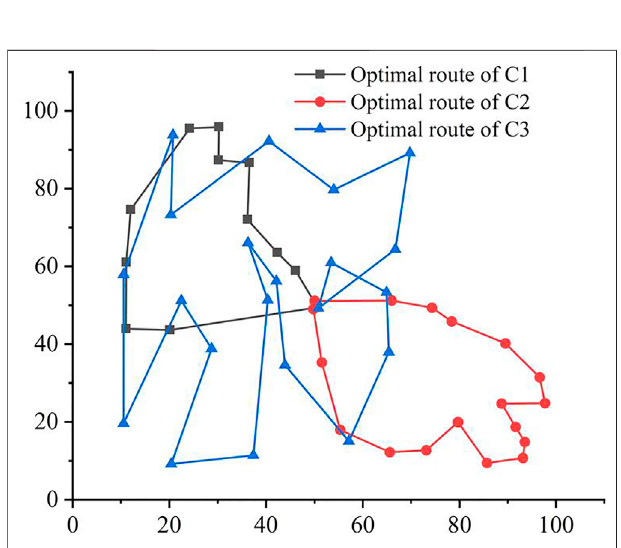
FIGURE 4 | Optimal route of